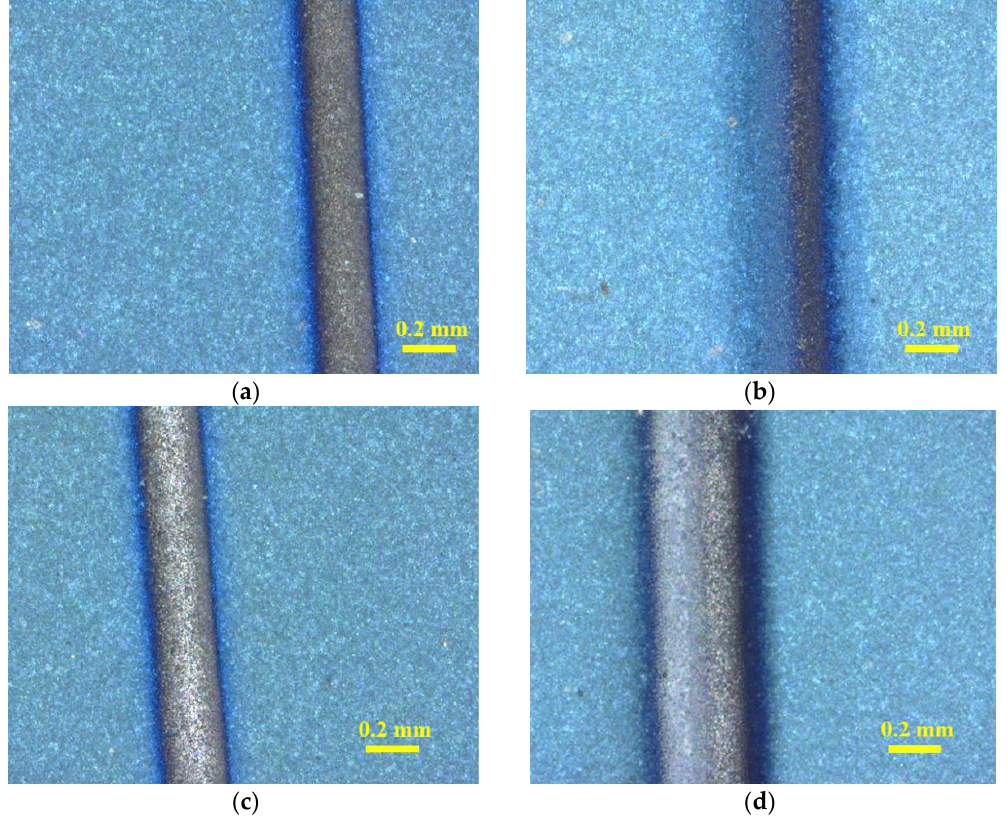
Figure 4. Treated Si x N y film deposited on silicon substrate on which He:CF 4 = 700:300 sccm and Ar:CF 4 = 700:300 sccm at V pp = 9.8 kV: ( a ) t e = 120 s in Ar / CF 4 mixture; ( b ) t e = 120 s in He / CF 4 mixture; ( c ) t e = 180 s in Ar / CF 4 mixture; ( d ) t e = 180 s in He / CF 4 mixture.